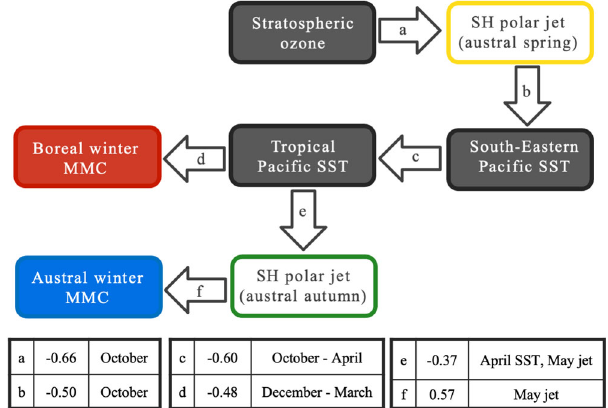
Fig. 9 Propagation of anomalies in atmospheric and ocean circulation from austral spring to austral winter. Relationships ( a – f ) are supported by correlations shown in Supplementary Fig. S12. Averaged correlation coef fi cients for selected months across different time periods are given in the table. Stratospheric ozone is represented by the ozone mixing ratio at 100 hPa at 60 – 90°S, the SH polar jet by zonal mean zonal wind speed between 55 – 65°S, South-Eastern and Tropical Paci fi c SSTs are averaged across (47 – 62°S, 140 – 70°W) and (5°N – 5°S, 170 – 120°W), respectively. Frequency of NW 2 and SW 2 are used for boreal and austral winter